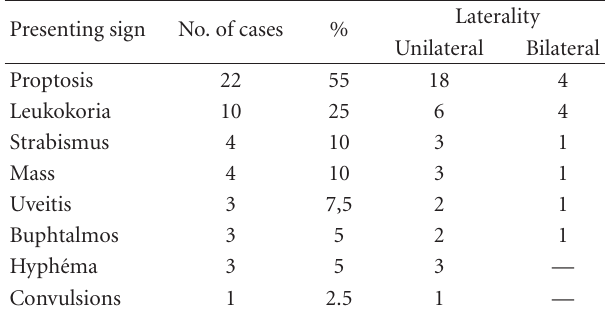
Table 1: First symptoms in 40 patients with retinoblastoma. Table 2: Presenting signs in 40 patients with